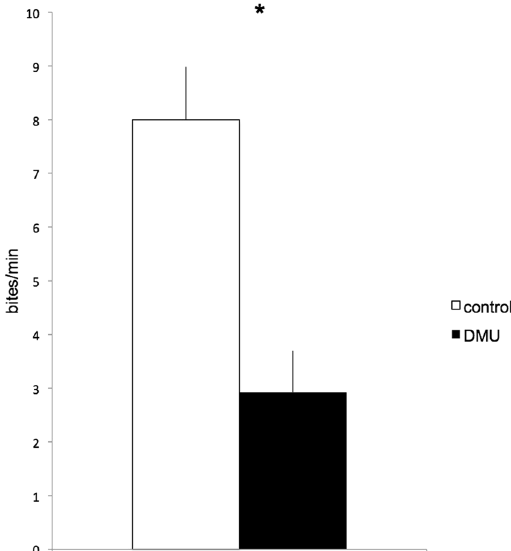
Figure 1. Frequency of bites per minute against the mirror in control (white bar) and DMU stimulated males (black bar). N DMU = 22, N control = 11 Significant differences at P < 0.05 are marked with * . See text for details.